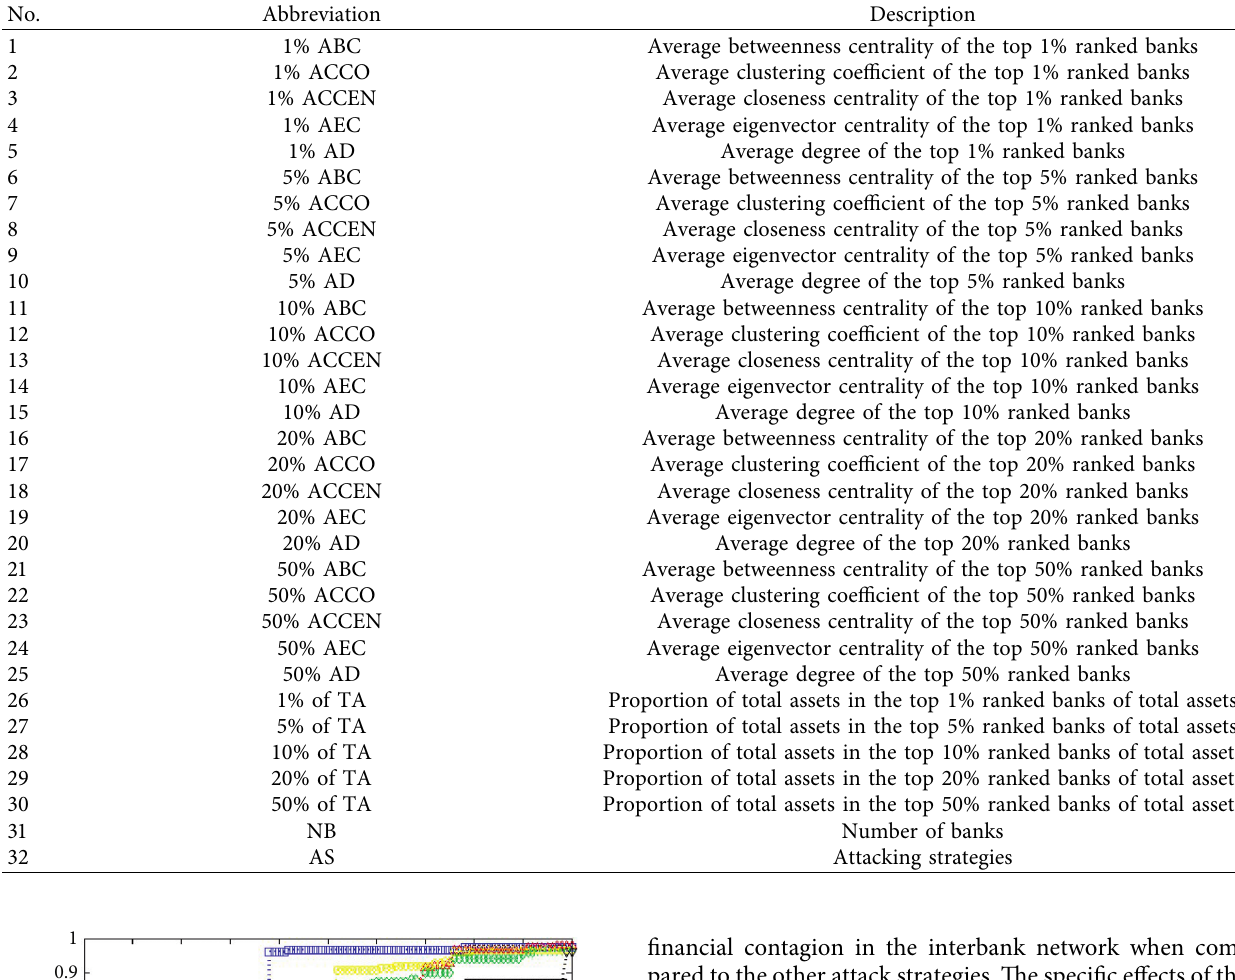
Table 2: The set of features considered in the interbank network.